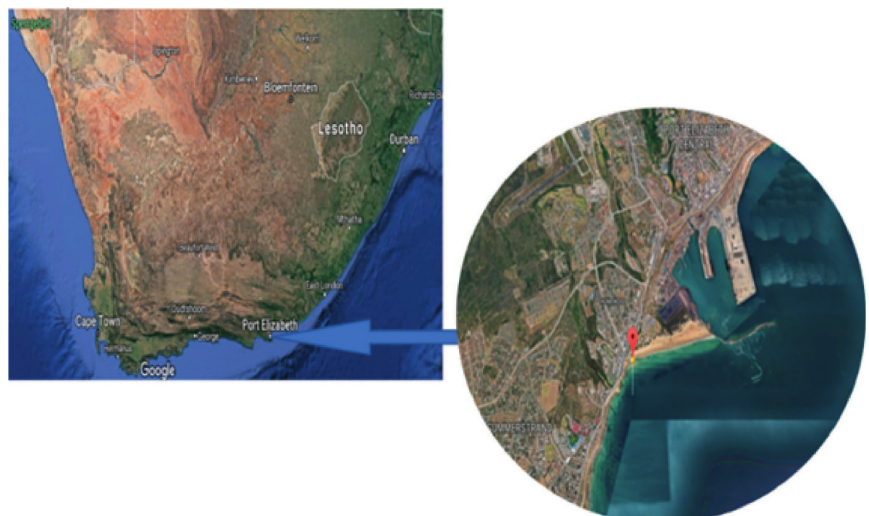
Figure 1: The geographical location of Phillips Reef in Algoa Bay, Port Elizabeth, South